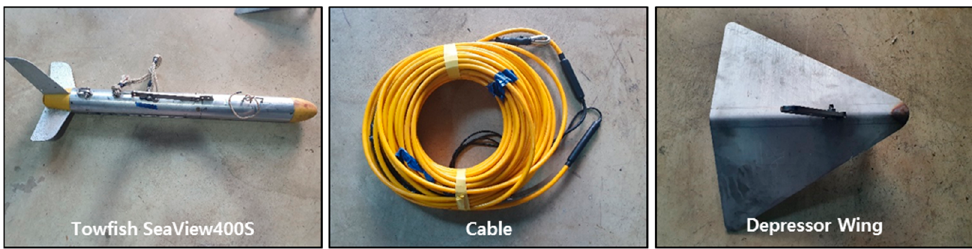
Figure 4. Side scan sonar with towfish, cable, and depressor wing used in experiments.